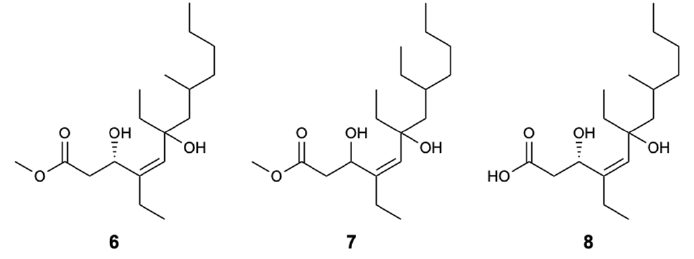
Figure 5. Structures of woodylides A–C ( 6 – 8 ).